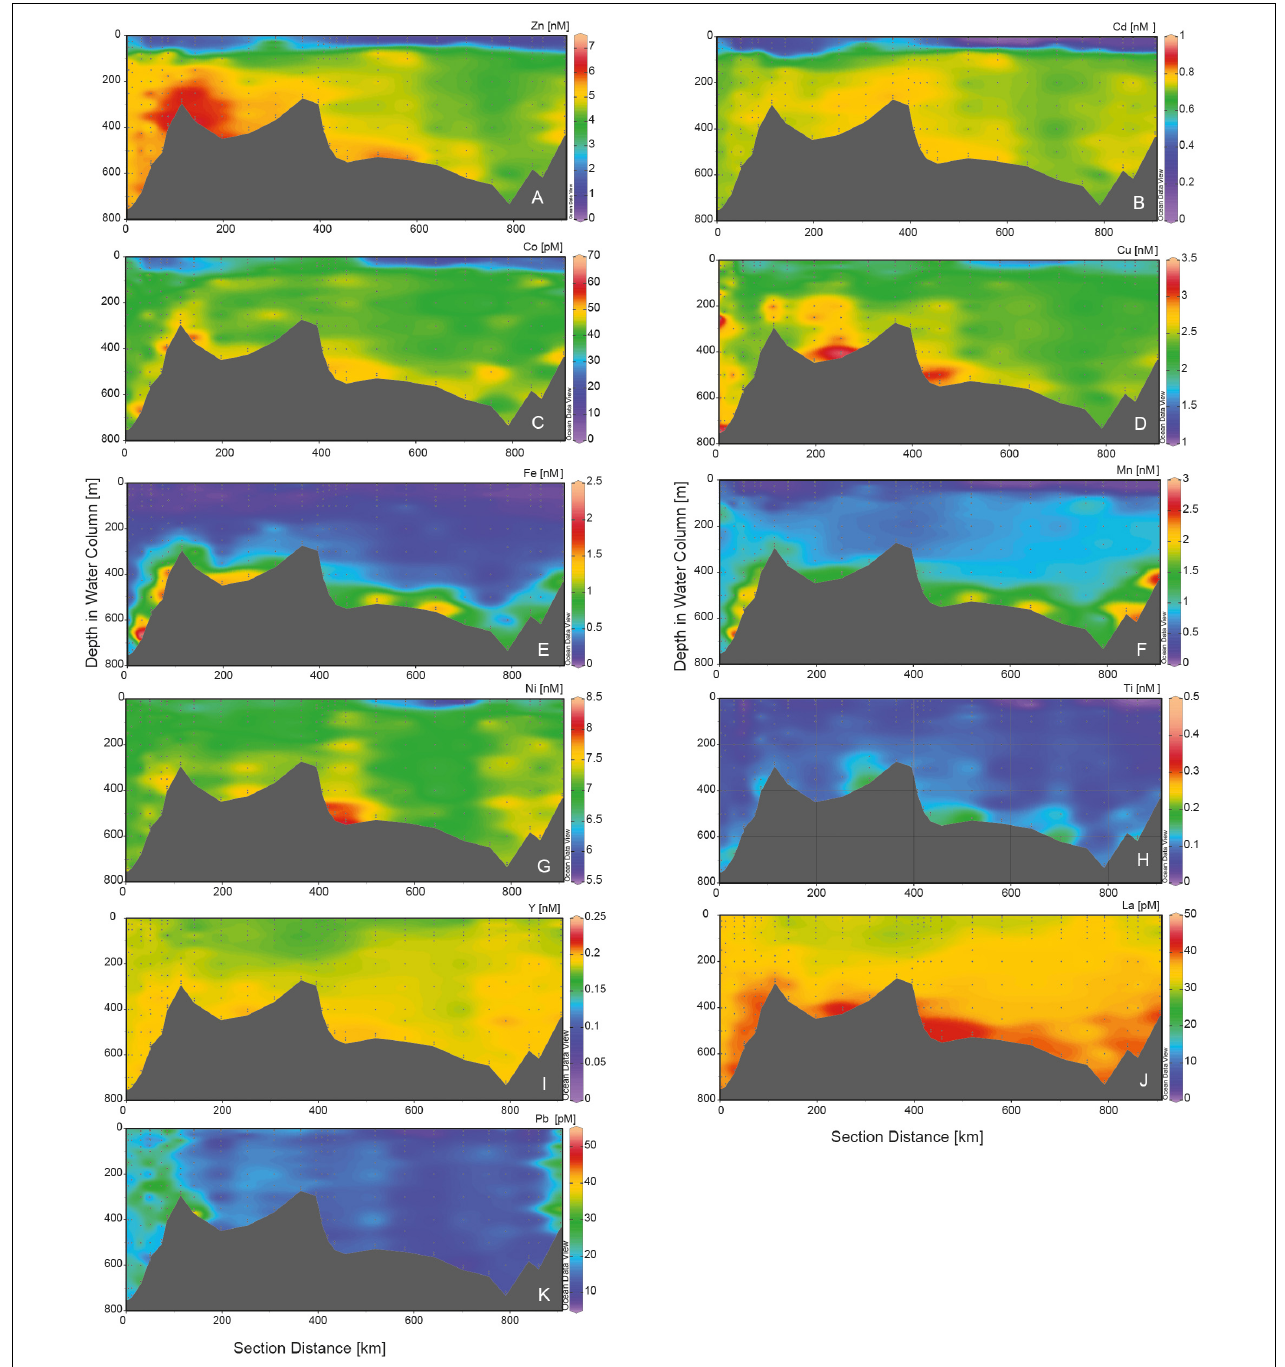
FIGURE 4 | Transects of dissolved trace metals along the circle in the Ross Sea Polynya. Metals are in nM, with the exception of DCo, DLa, and DPb which are in pM. Stations 16–18 and the stations 88–90 near Franklin Island are omitted. (A) DZn, (B) DCd, (C) DCo, (D) DCu, (E) DFe, (F) DMn, (G) DNi, (H) DTi, (I) DY, (J) DLa, and (K) DPb. Figure made using ODV (Schlitzer, 2018).